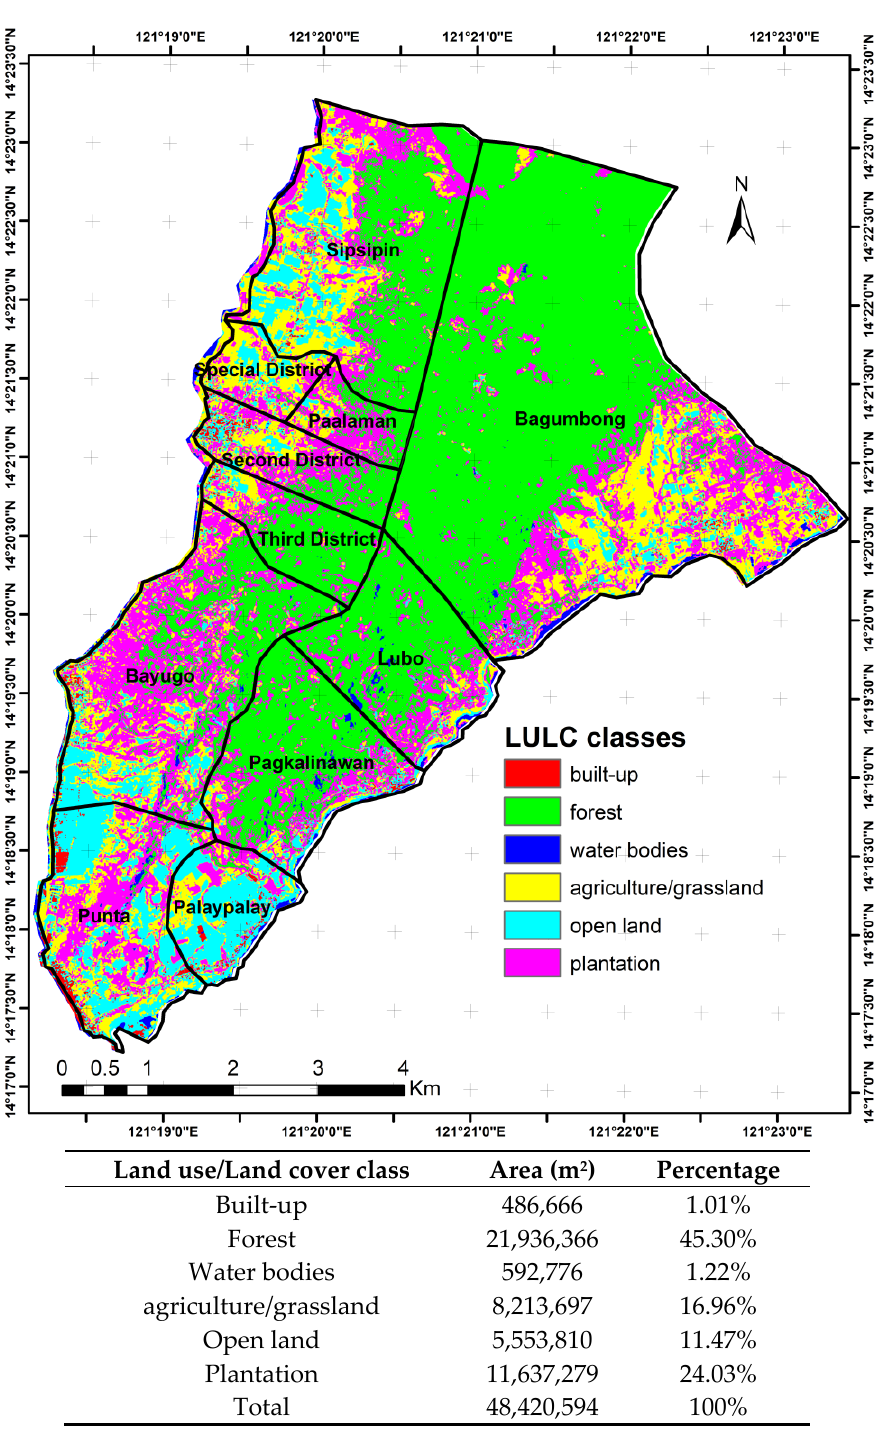
Figure 3. Land use land cover map of Jala-Jala peninsula.